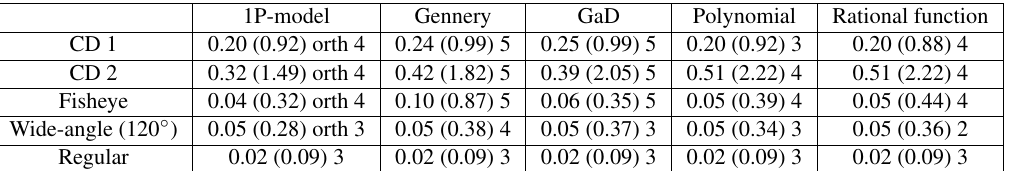
Table 2: Results of showcase calibrations